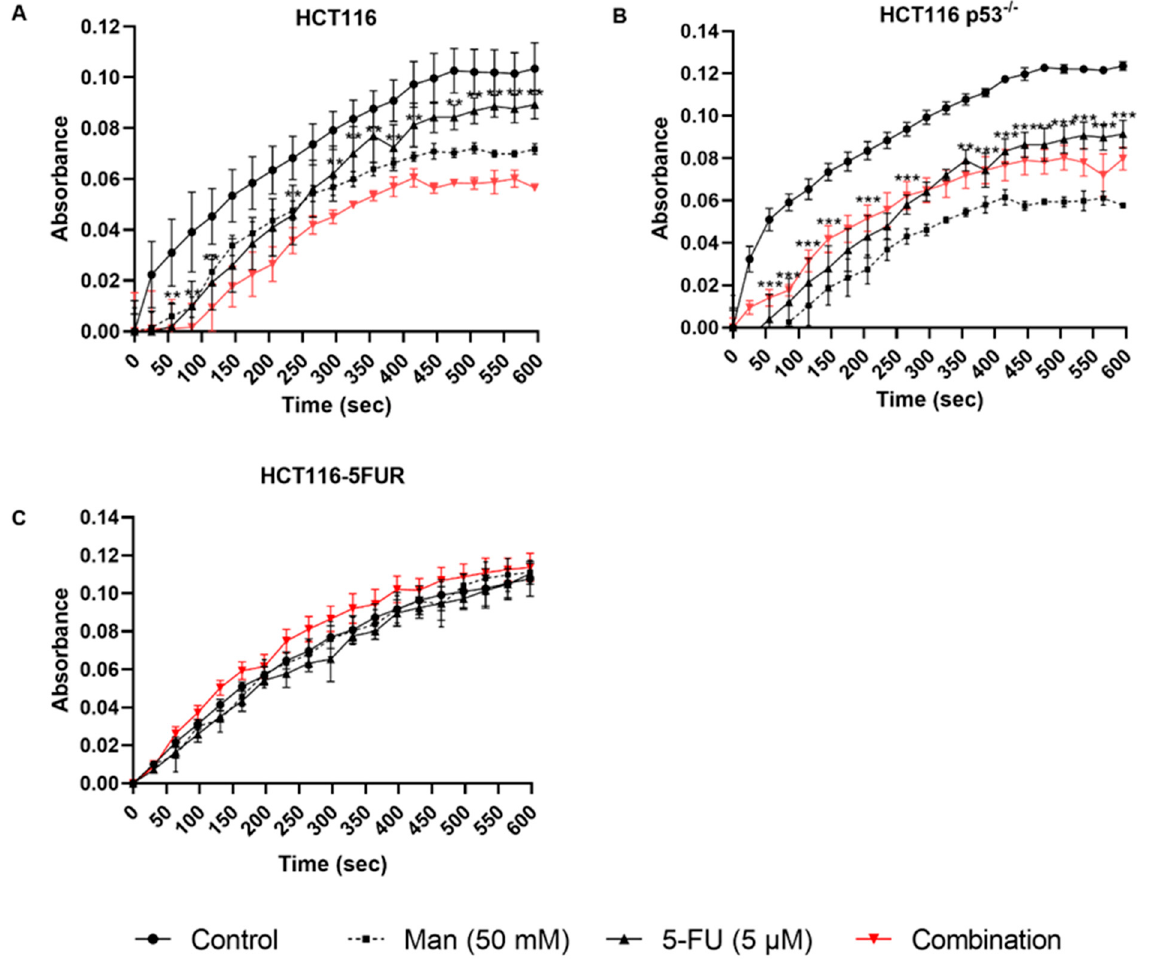
Figure 5. Effect of mannose alone or in combination with 5-FU on the total dehydrogenase activity of the PPP in human colorectal cancer cells. ( A ) HCT116; ( B ) HCT116 p53 − / − ; ( C ) HCT116-5FUR cells. Total dehydrogenase activity was determined in triplicate measurements and was measured spectrophotometrically by monitoring the change in absorbance at 340 nm for 5 min. Results represent an average of three independent experiments ± SEM. ** p < 0.01, and *** p < 0.001 are considered statistically signi fi cant.